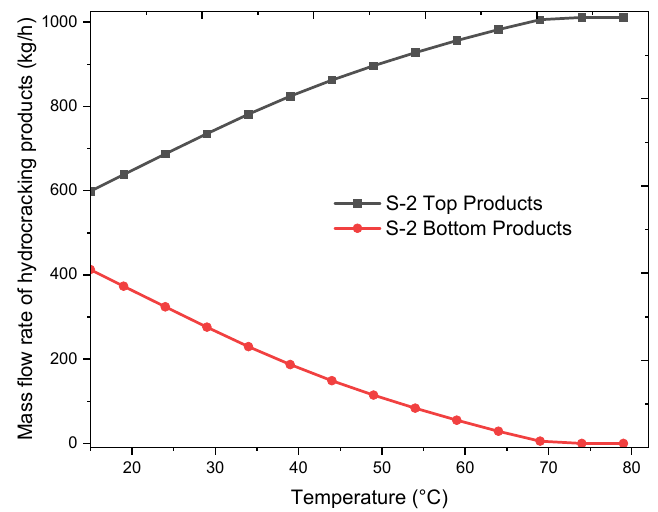
Figure 6. Sensitivity and optimization analysis of the hydrocracking process.